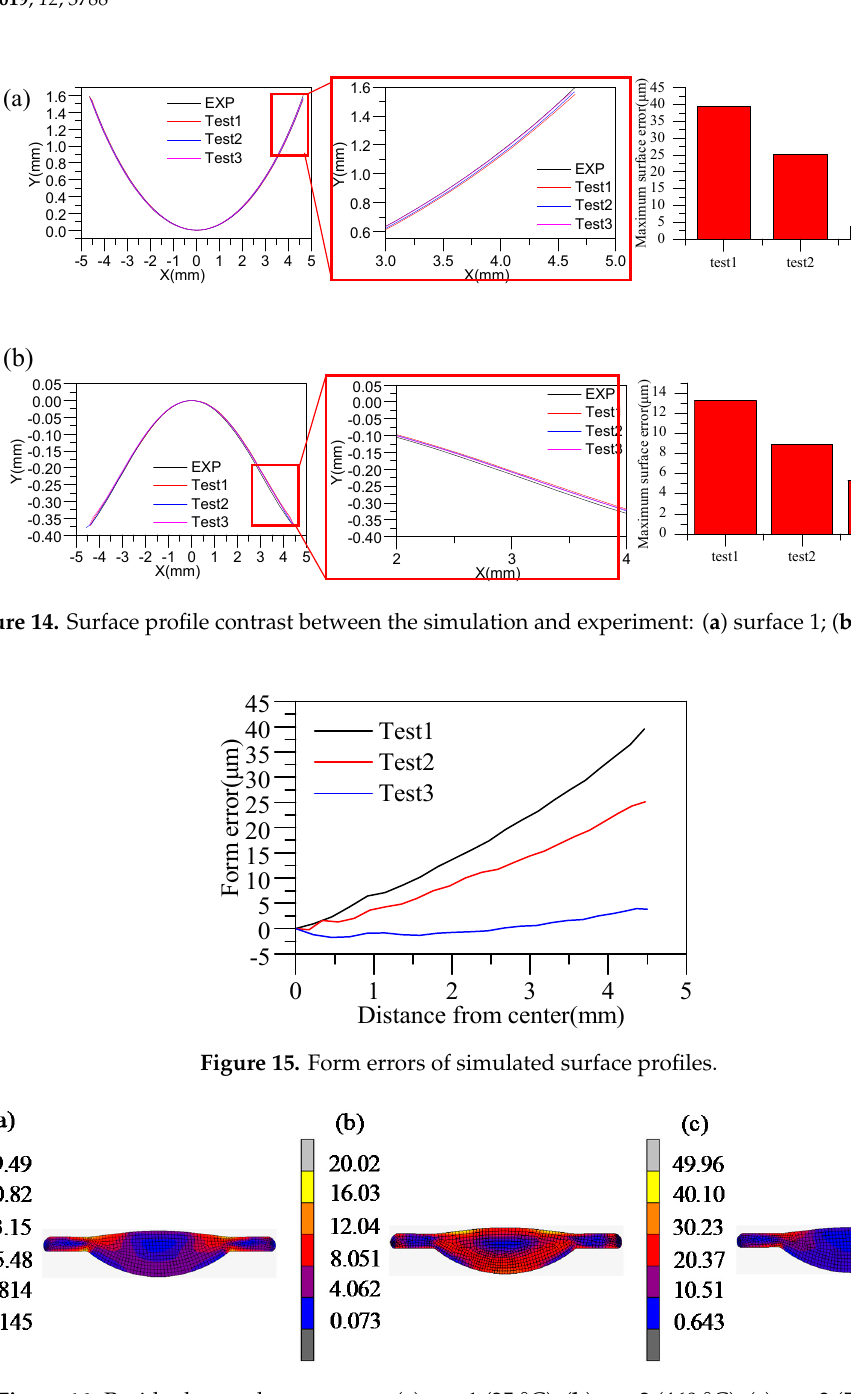
Figure 16. Residual stress lens contrast: ( a ) test 1 (25 °C); ( b ) test 2 (460 °C); ( c ) test 3 (550 °C).